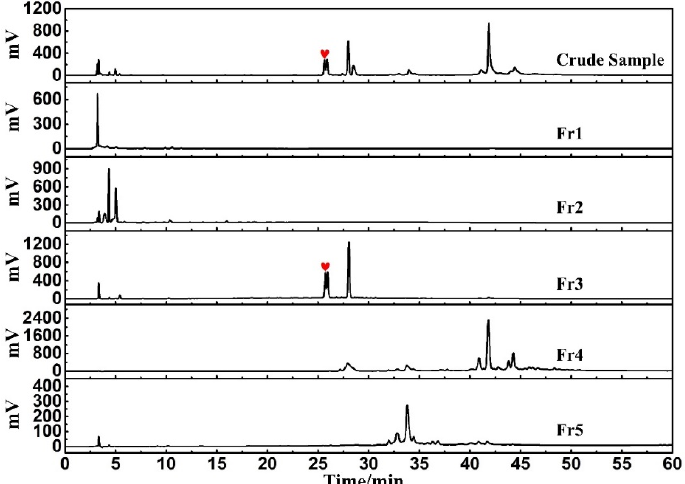
Figure 3. Analysis chromatograms of crude sample, Fr1, Fr2, Fr3, Fr4, and Fr5 under the same chro ‐ matographic condition. chromatographic